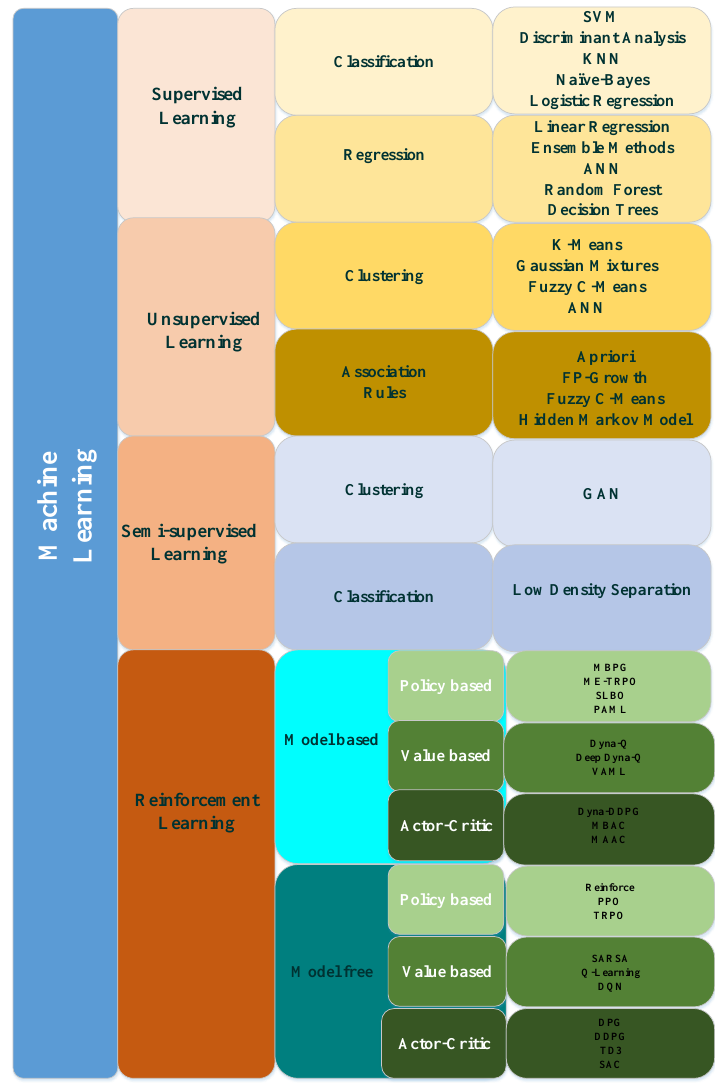
Figure 5. Different types of machine